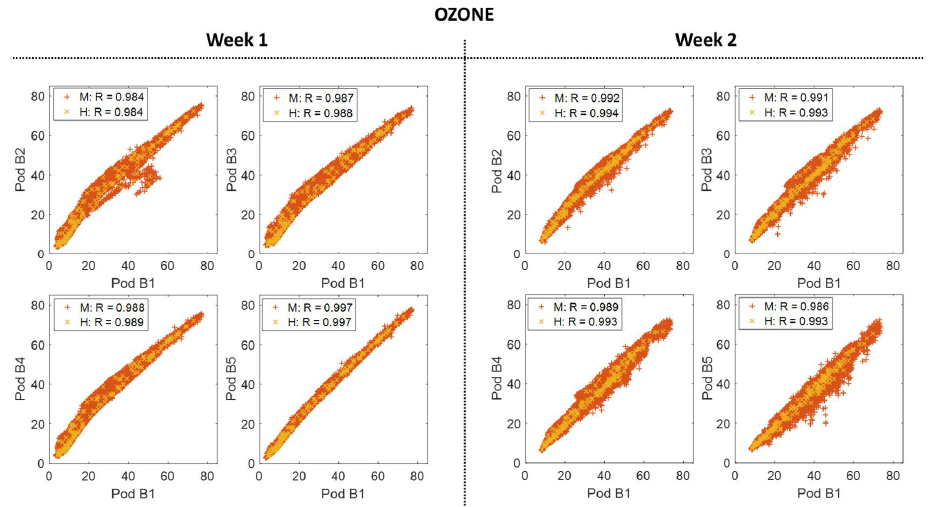
Figure 6. The scatter plots to the left show the correlation between Y-Pod B1 and each of the added building Y-Pods (B2, B3, B4, and B5) for both minute (M) and hourly (H) O 3 data for Week 1 (co-located). The scatter plots to the right show the same correlations, again with minute and hourly data, for Week 2 when they were spatially deployed around the building site.